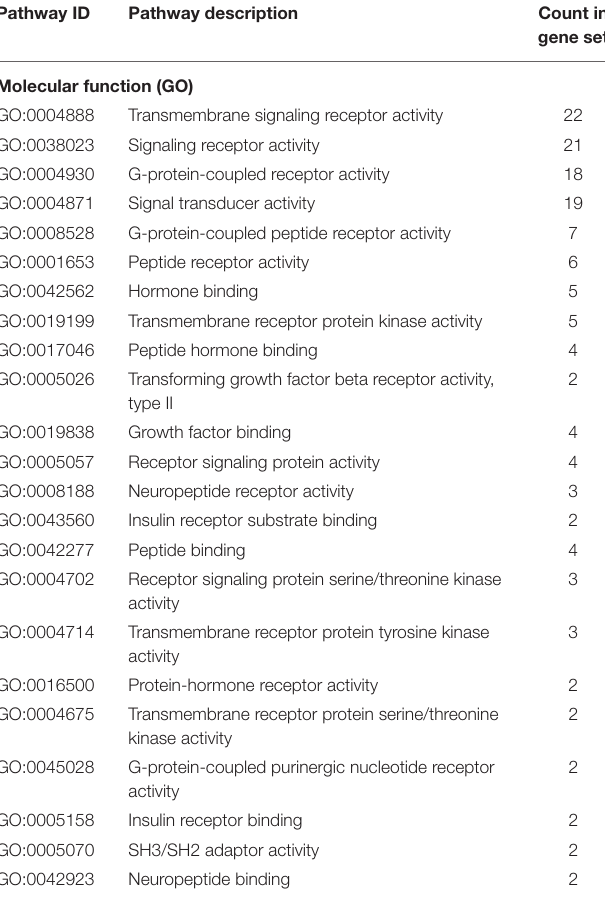
TABLE 2 | List of the top 10 GO molecular function pathways affected by differentially regulated genes (33) in GnRH neurons of proestrous mice. Pathway